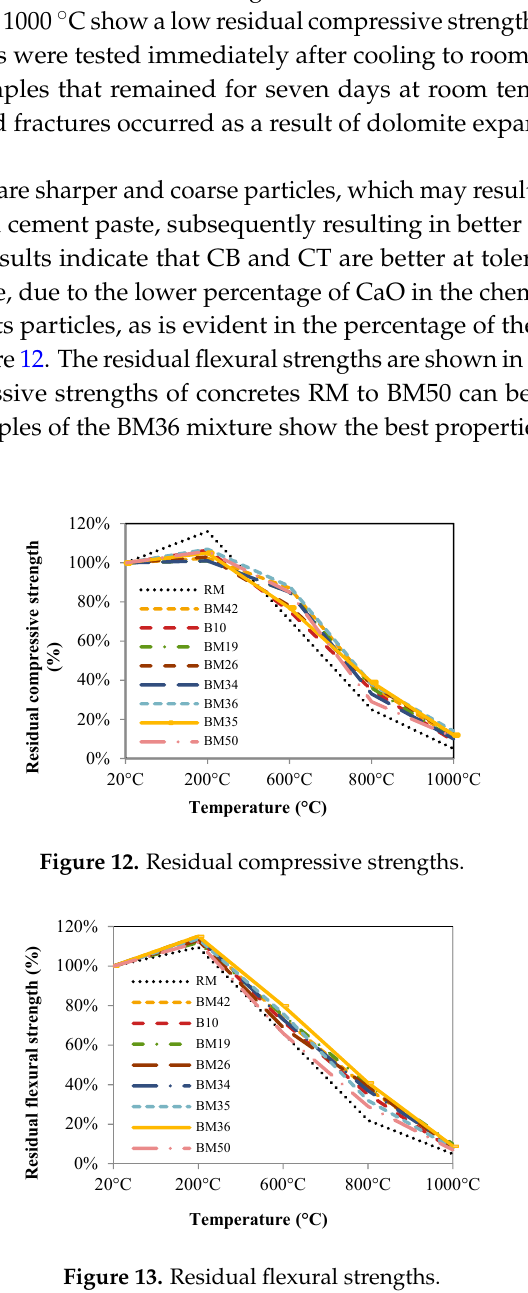
Figure 13. Residual flexural strengths.